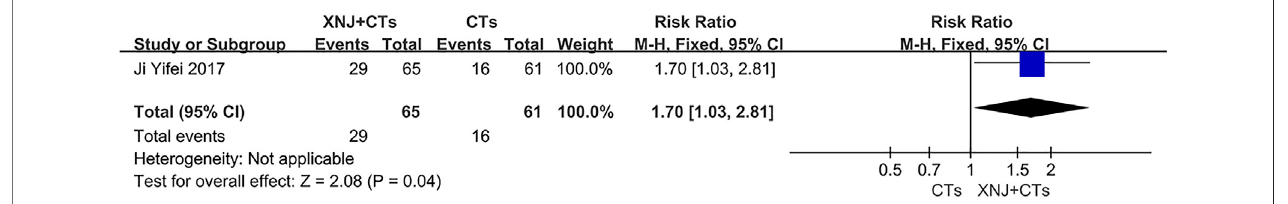
FIGURE 3 | Forest plot of the functional independence